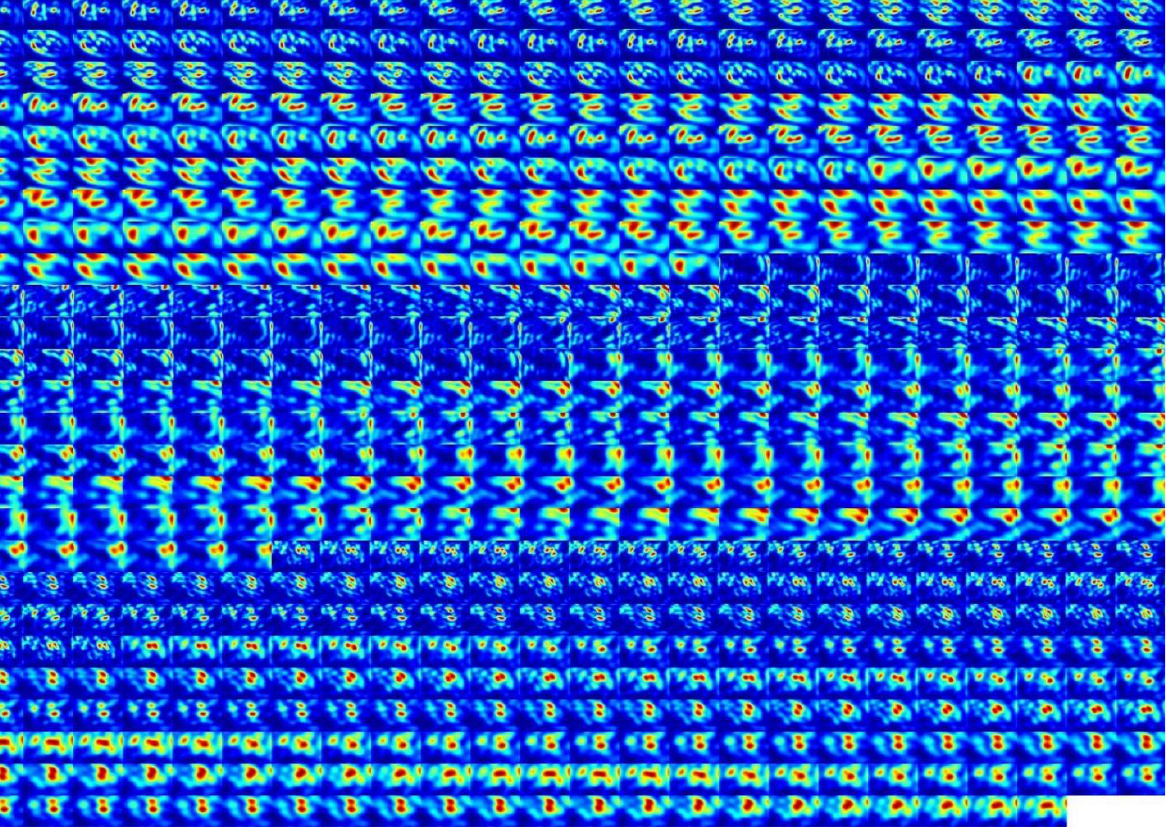
Figure 6. CWT with a gaussian mother wavelet produced raw 3D spectral features with three scales in 72 directions (0°, 5°, 10°, …, 355°). The extracted features are sliced at an elevation of 1000 m.